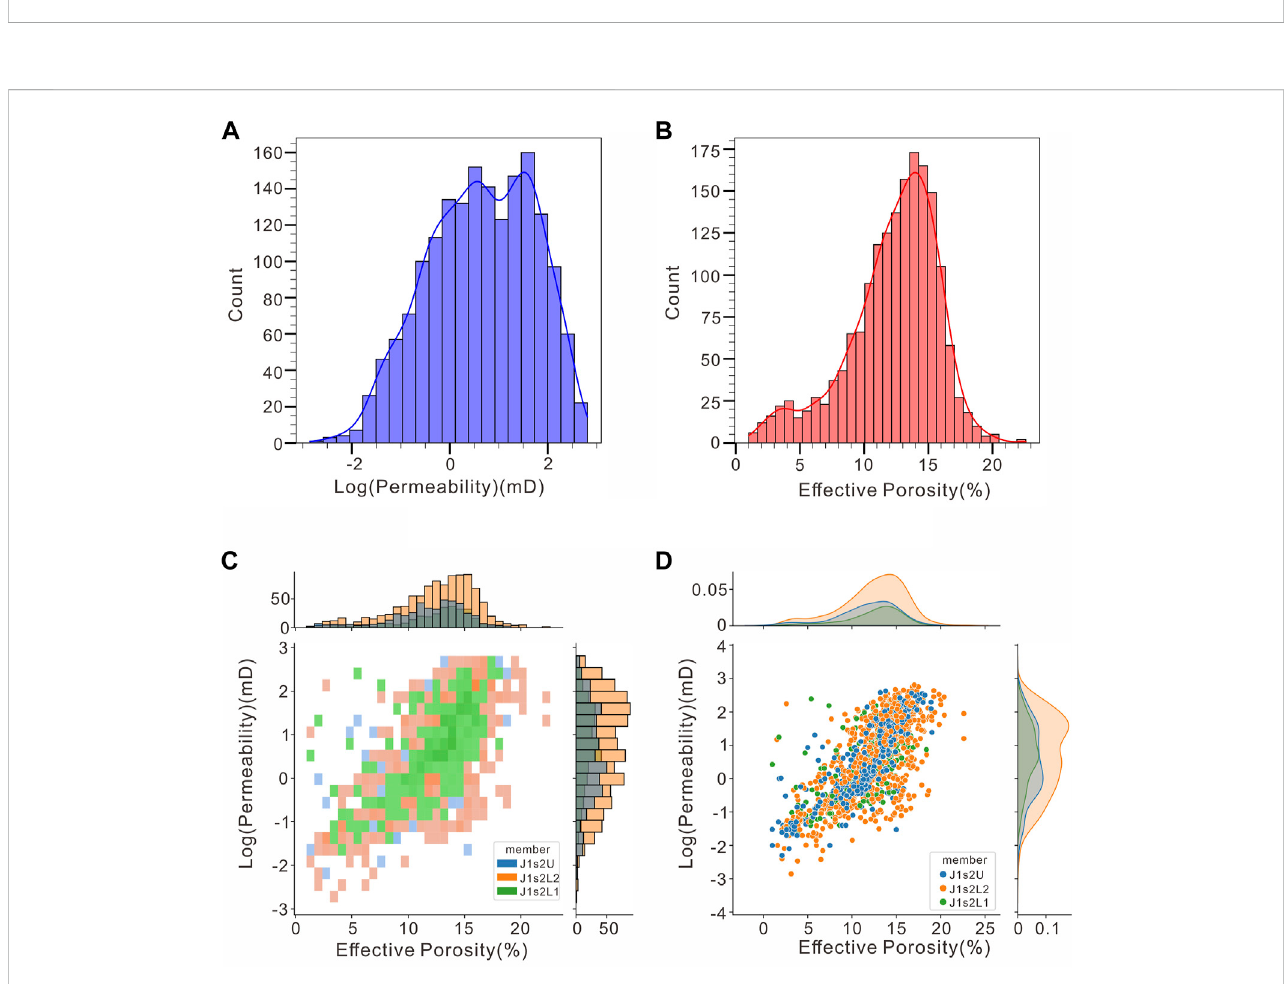
FIGURE 2 Porosity and permeability frequency histograms and joint probability distribution of the second section of t J 1 s 2 in the Moxizhuang area. (A) Horizontal permeability frequency histogram. (B) Effective porosity frequency histogram. (C) Joint probability distribution of effective porosity and horizontal permeability(Differentcolorsrepresentdifferentmembers). (D) Cross-plotofeffectiveporosityandhorizontalpermeability(Subplotsarekerneldensityplots).